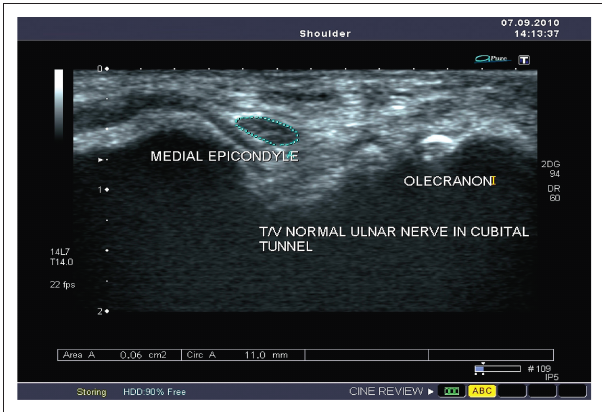
Source : T. Roodt. FIGURE 5: Ultrasound image of the normal ulnar nerve (CSA 0.06 cm 2 ) in a transverse plane, at the level of the medial epicondyle, with the elbow in flexion. The cross-sectional area was manually traced within the echogenic rim.